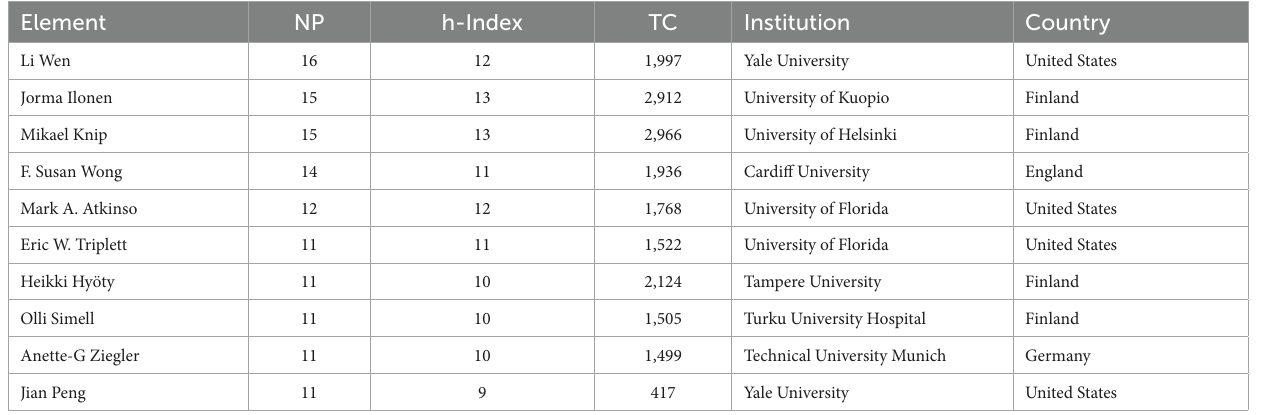
TABLE 3 Top 10 most influential